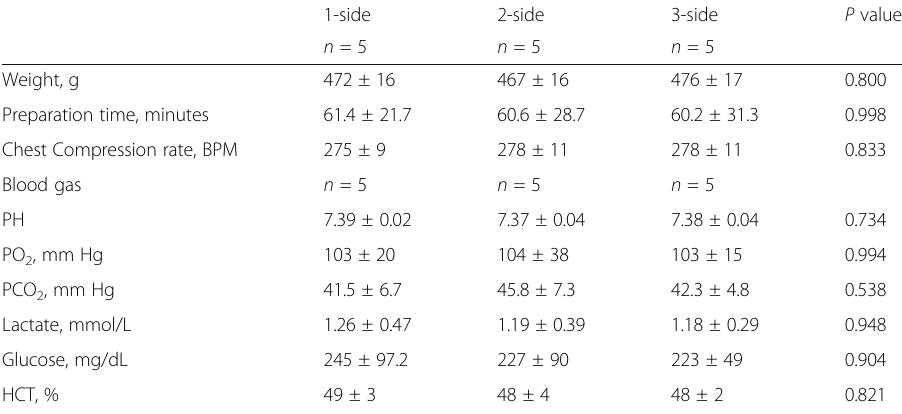
Table 1 The basal background including operative time and chest compression rate